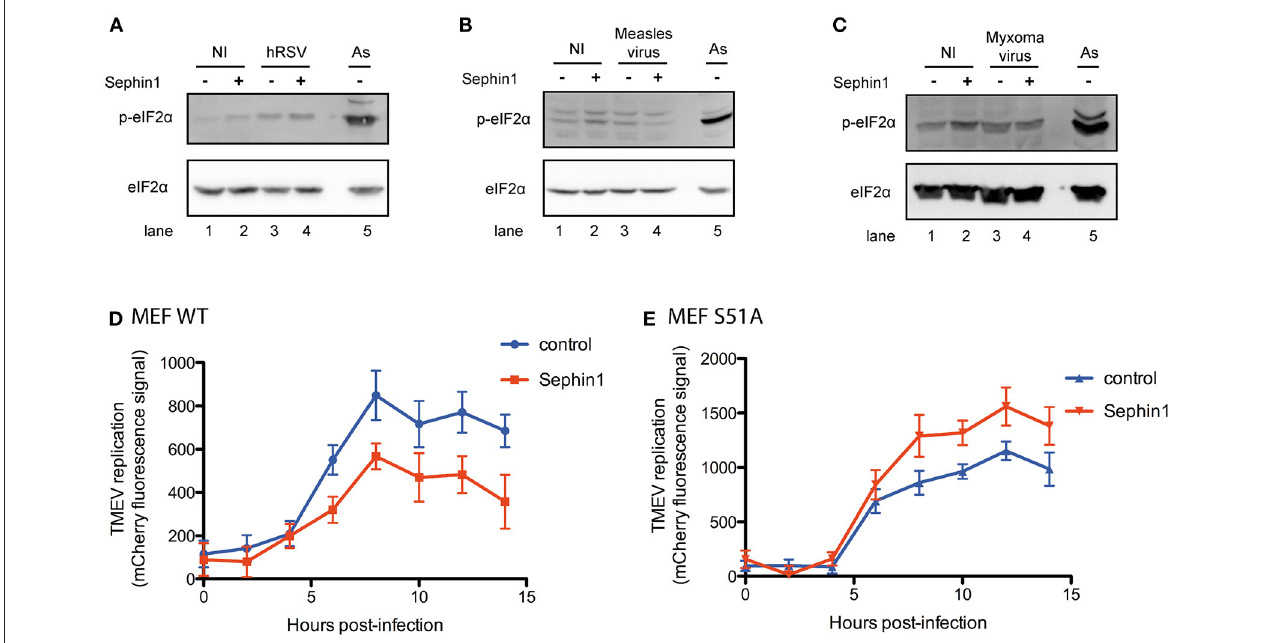
FIGURE 10 | Evaluation of the contribution of eIF2 α phosphorylation to the antiviral effects of Sephin1. Cells were either left non-infected (NI) or infected with the indicated viruses, in the presence or absence of 50 µ M Sephin1. Sodium arsenite (As), a potent inducer of eIF2 α phosphorylation, was used as a positive control for detection of eIF2 α phosphorylation by western-blot. (A) Analysis of eIF2 α phosphorylation in HEp-2 cells infected with hRSV. (B) Analysis of eIF2 α phosphorylation in HEK293T cells infected with measles virus. (C) Analysis of eIF2 α phosphorylation in RK13 cells infected with myxoma virus. (D) Consequences of Sephin1 treatment on TMEV replication in WT mouse embryonic fibroblasts (MEF WT). (E) Consequences of Sephin1 treatment on TMEV replication in mouse embryonic fibroblasts expressing a non-phosphorylable (S51A) allele of eIF2 α (MEF S51A). TMEV replication was determined by measuring mCherry fluorescence. Data represent mean ± SEM from representative experiments, repeated at least three